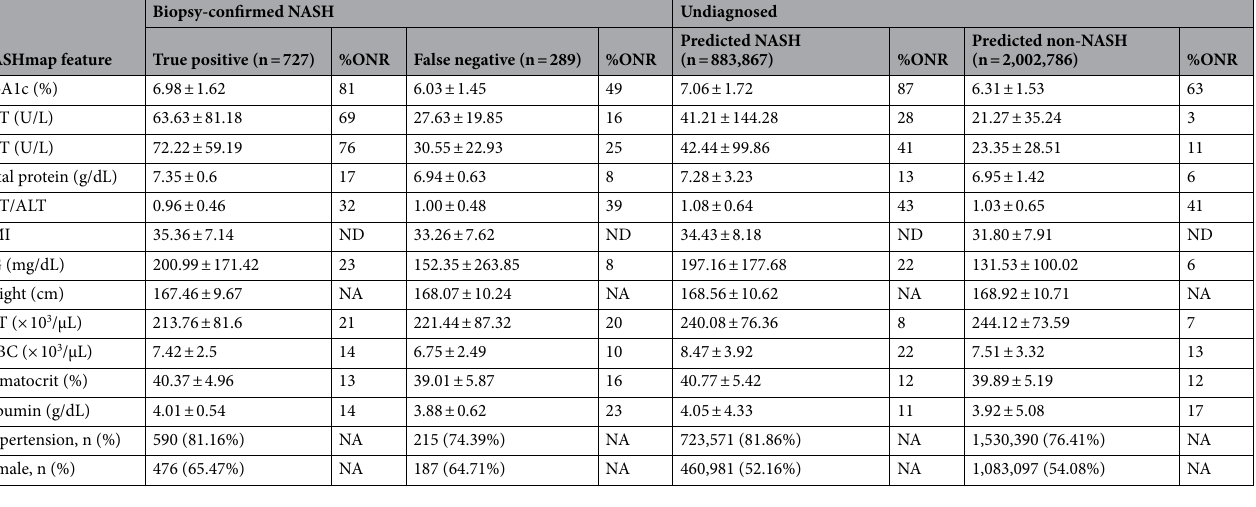
Table 5. Clinical features of Optum real-world database patients predicted as NASH or non-NASH by NASHmap. Data are presented as mean ± SD unless otherwise stated. NASH: nonalcoholic steatohepatitis; %ONR: % out of normal range; ND: not determined; NA: not applicable; HbA1c: glycated hemoglobin; AST: aspartate transaminase, ALT: alanine transaminase; BMI: body mass index; TG: triglycerides; ONR: outside normal range; PLT: platelets; WBC: white blood